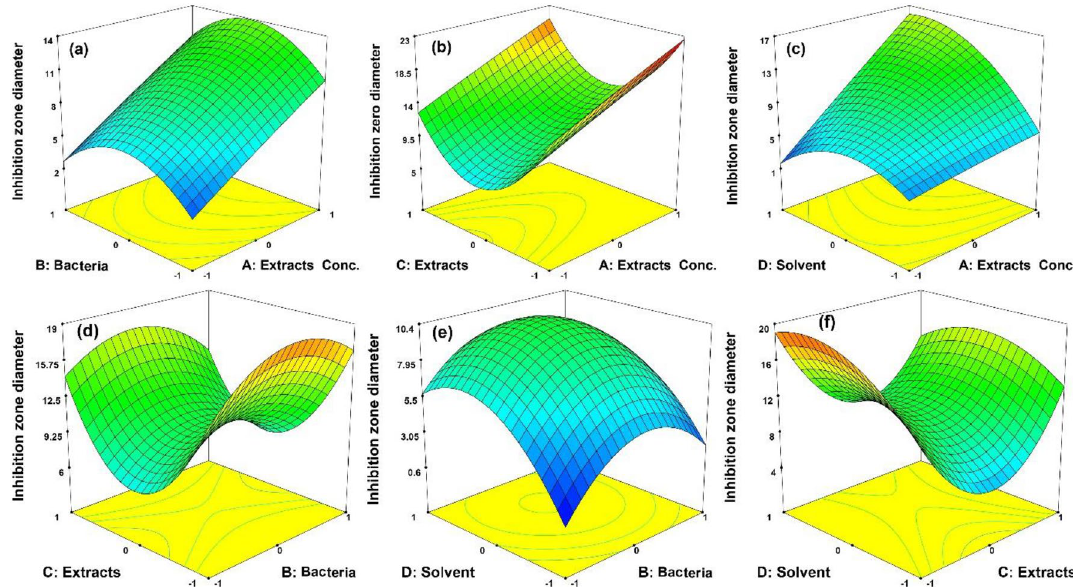
Figure 2. 3D plots of interaction between ( a ) Bacteria and Extract concentration, ( b ) Extracts and Extract concentration, ( c ) Solvents and Extract concentration, ( d ) Extracts and Bacteria, ( e ) solvents and Bacteria, ( f ) solvents and Extracts in inhibitory zone diameter of antibacterial activity of combined Punica granatum L. and Areca nut